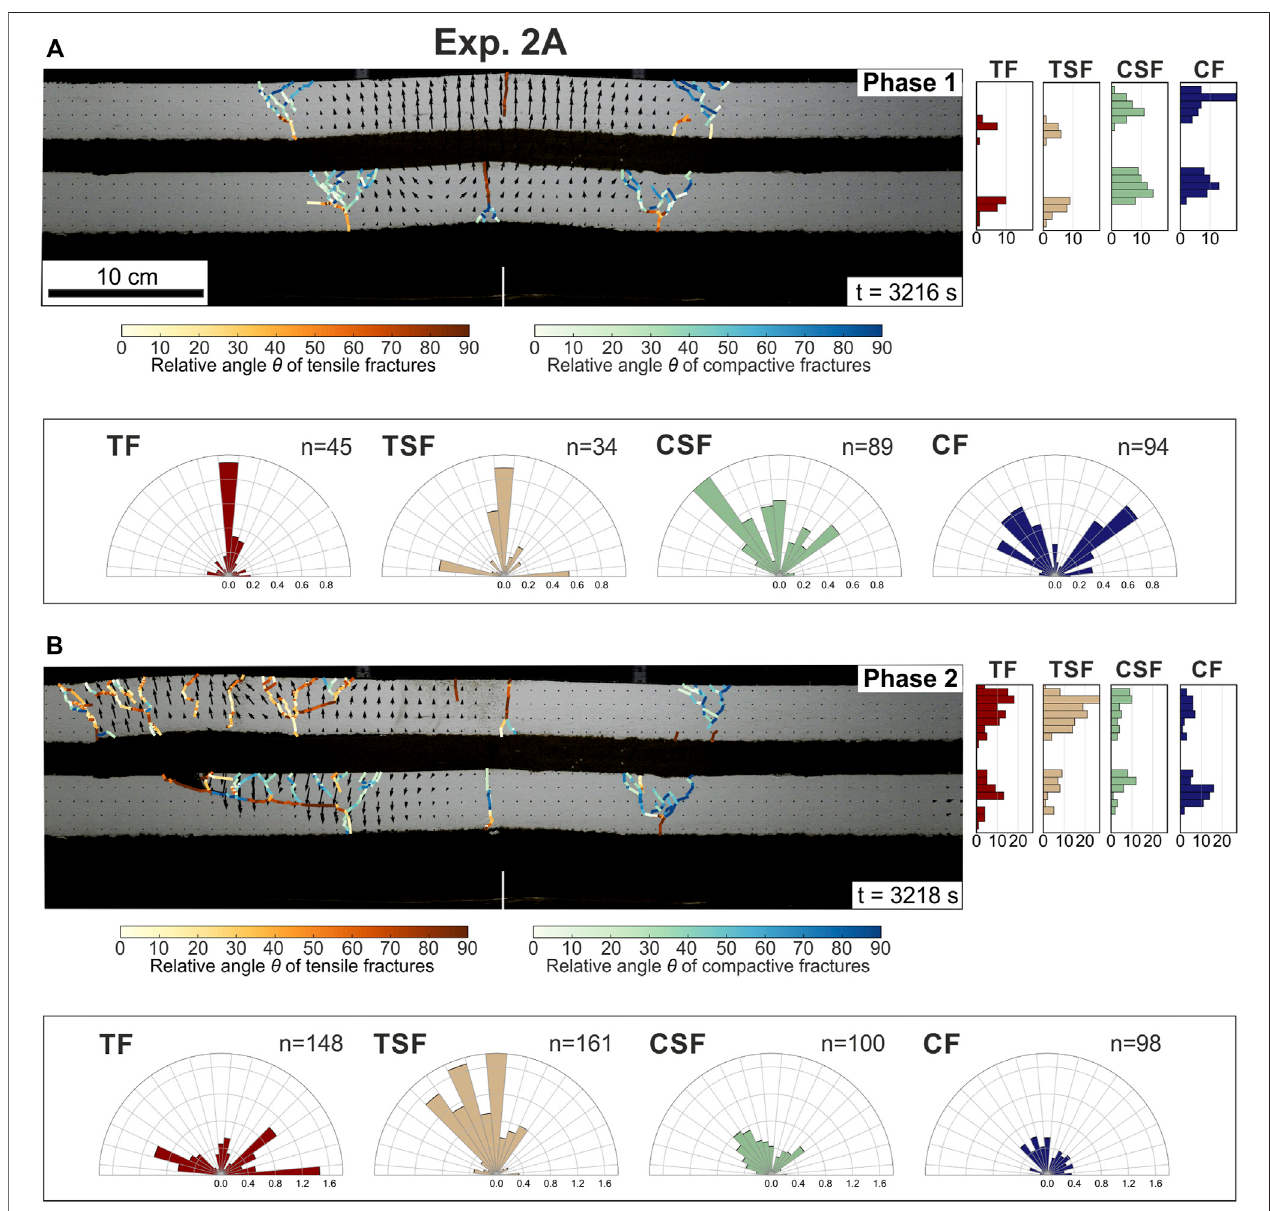
FIGURE9| Resultsofthefracturemodeanalysisofthe2Dexperiment2Afor (A) phase1and (B) phase2showingtheopeningmodeofthefracturescolor-coded. The opening mode is determined by the relative angle θ between the dip of the fracture and the displacement vectors (black arrows). If θ is larger than 45 ° , the fracture is dominated by tensile (red) or compactive (blue) movement, respectively. In case θ is smaller than 45 ° , the fracture is dominated by tensile-shear (orange) or compactive shear(green), respectively. Thebar plots totheright display theamount ofthespeci fi cfracture types forcertain depthintervals (onlywing fractures included). Rose diagramsdisplaythedipangles α ofthetensile(TF),tensile-shear(TSF),compactive(CF)andcompactive-shearfractures(CSF)normalizedbythelengthofeachfracture segment.